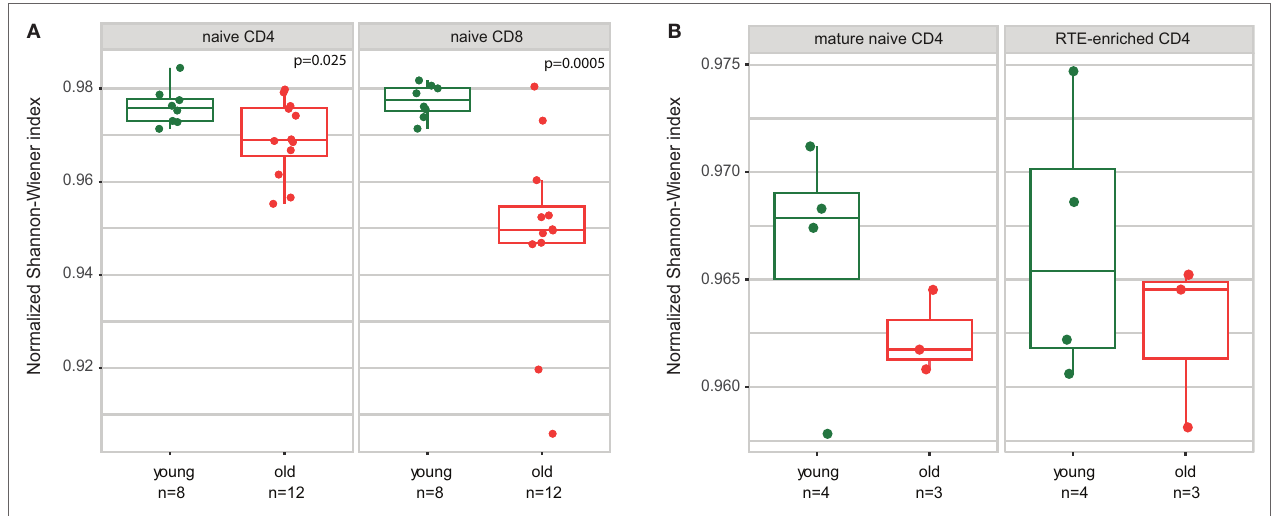
FigUre 2 | Both CD4 and CD8 naïve T cell clonality increases with human age. Normalized Shannon–Wiener diversity index for T-cell receptor beta CDR3 repertoires is shown. (a) CD4 and CD8 naïve T cells. Joint data from Qi and coauthors and current work. Welch Two Sample t -test. (b) Recent thymic emigrant (RTE)-enriched and non-RTE naïve CD4 T